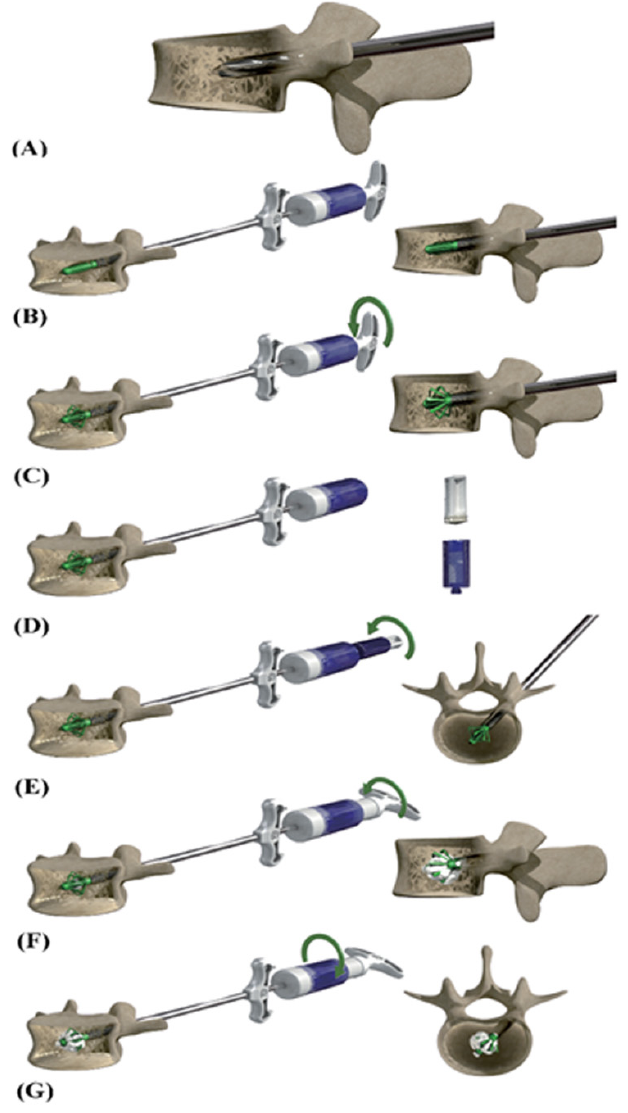
Figure 3. Schematic drawing showing the surgical procedure of EVA ® implantation. ( A ) Rotating the bone drill to drill into the desired position of vertebral body; ( B ) inserting the EVA ® implant into the vertebral body with the EVA ® operation device; ( C ) rotating the expander handle to expand the EVA ® implant. A fluoroscope was used to ensure the implant’s position and expansion; ( D ) the expander handle was completely unscrewed to disengage it. The cement injection syringe was filled with the cement mixture; ( E ) the cement injection syringe was insert into the EVA ® operation device, and the cement injection handle was attached to the EVA ® operation device; ( F ) the cement injection handle was rotated to inject the cement; and ( G ) the EVA ® operation device was rotated counterclockwise to disassemble the system and complete the procedure.